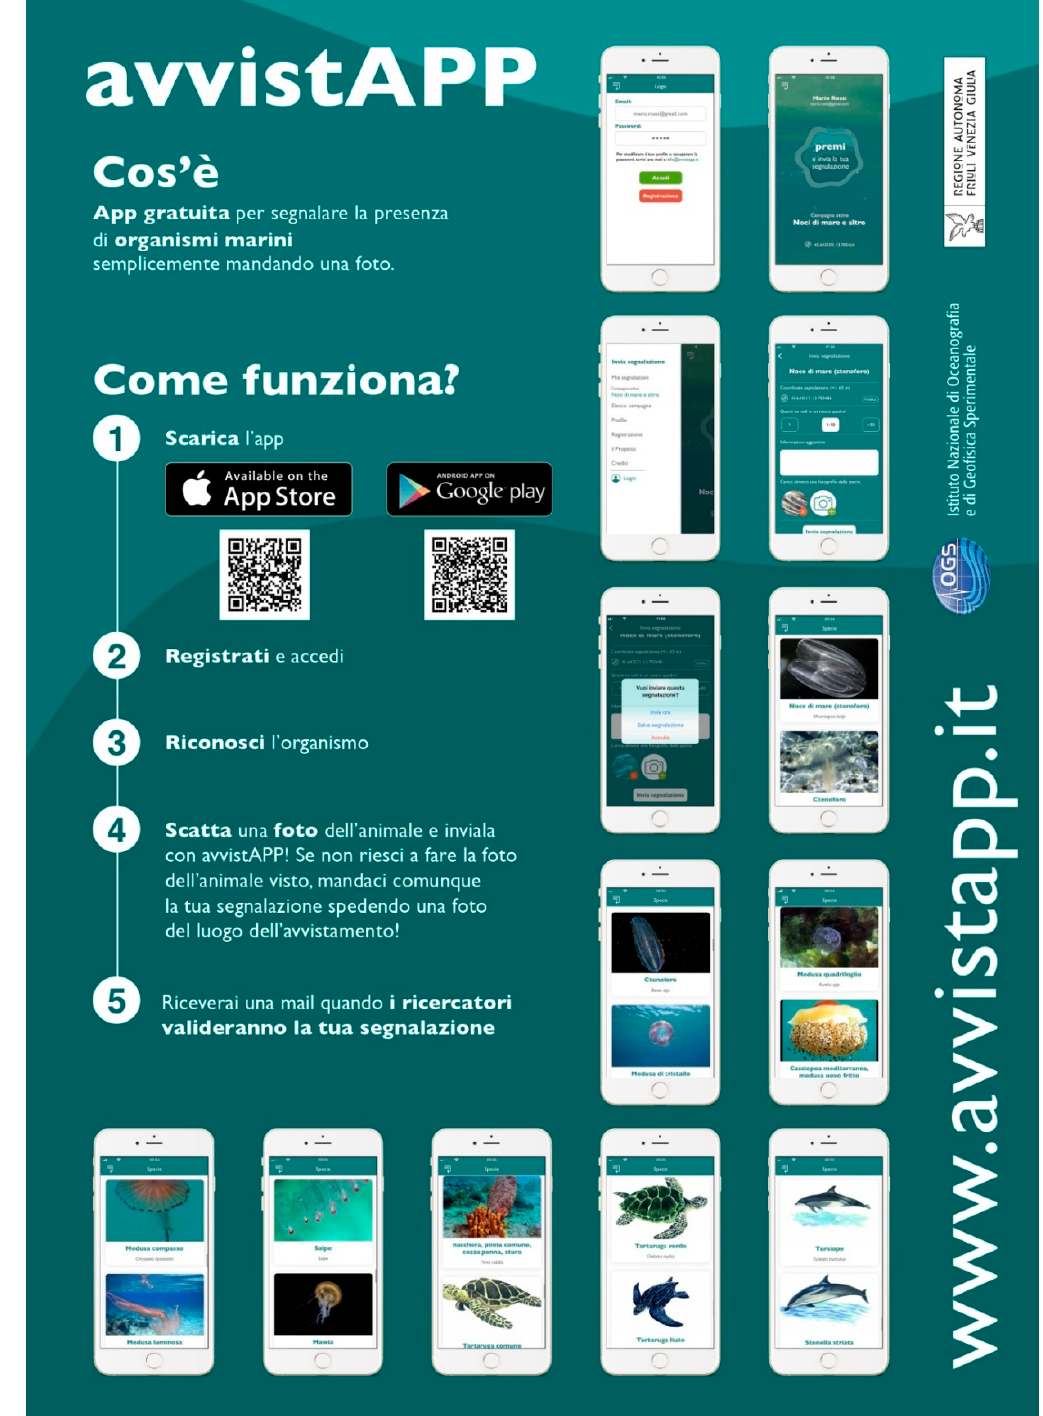
Figure 1. Example of a poster used to promote avvistAPP, showing its working. Step 1: download the app; step 2: register and log in; step 3: identify the organism; step 4: take a picture of the animal and send it through avvistAPP (if you are unable to take a photo of the animal seen, send us your report anyway by sending a photo of the place of the sighting); step 5: you will receive an email when researchers have validated your sighting.